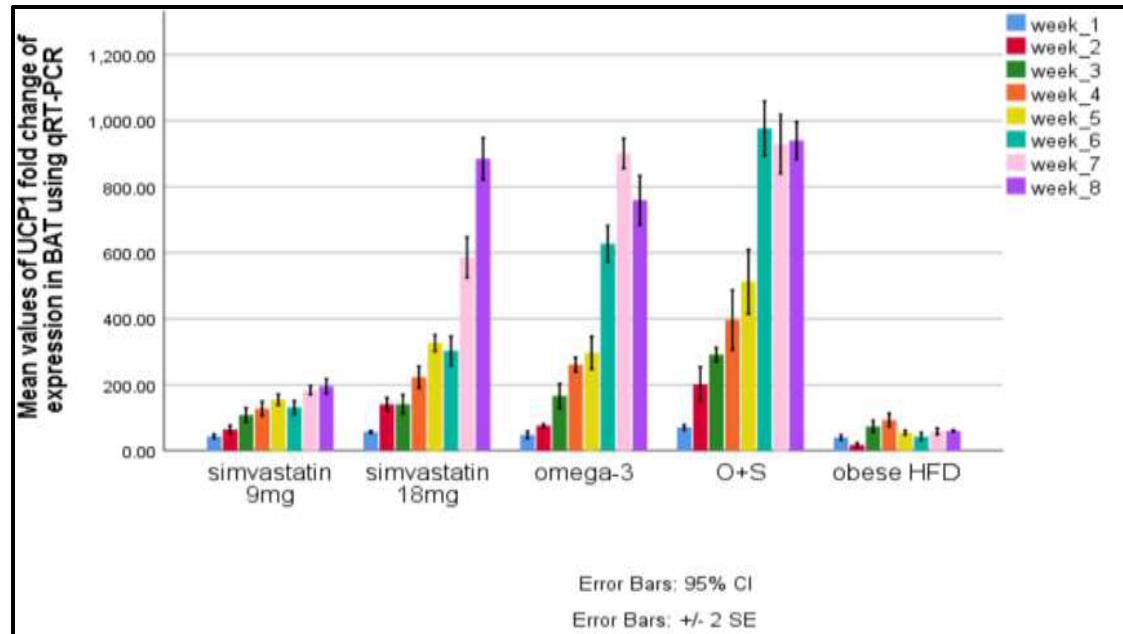
Figure 1. Effects of two-different doses of simvastatin, omega-3, and combination of simvastatin and omega3 on UCP 1 genes in brown adipose tissue (BAT).